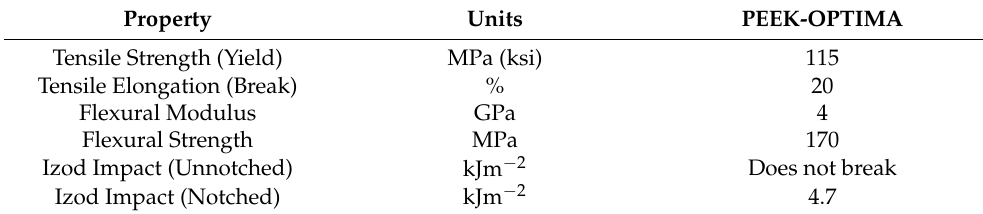
Table 1. Material properties PEEK.